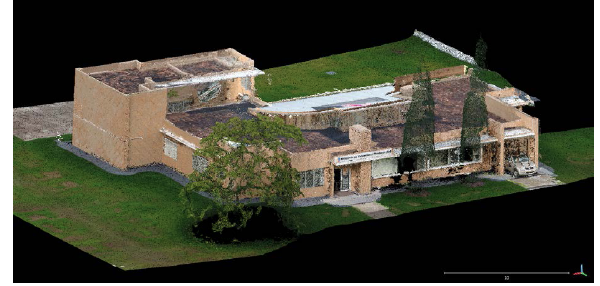
Figure 10: 3D model of “La Casa Peña”.